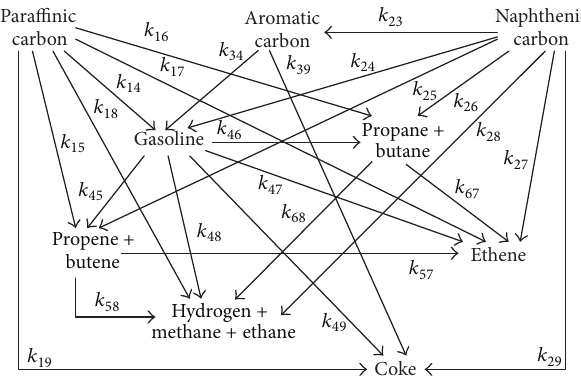
Figure 2: Reaction network of the nine-lump kinetic